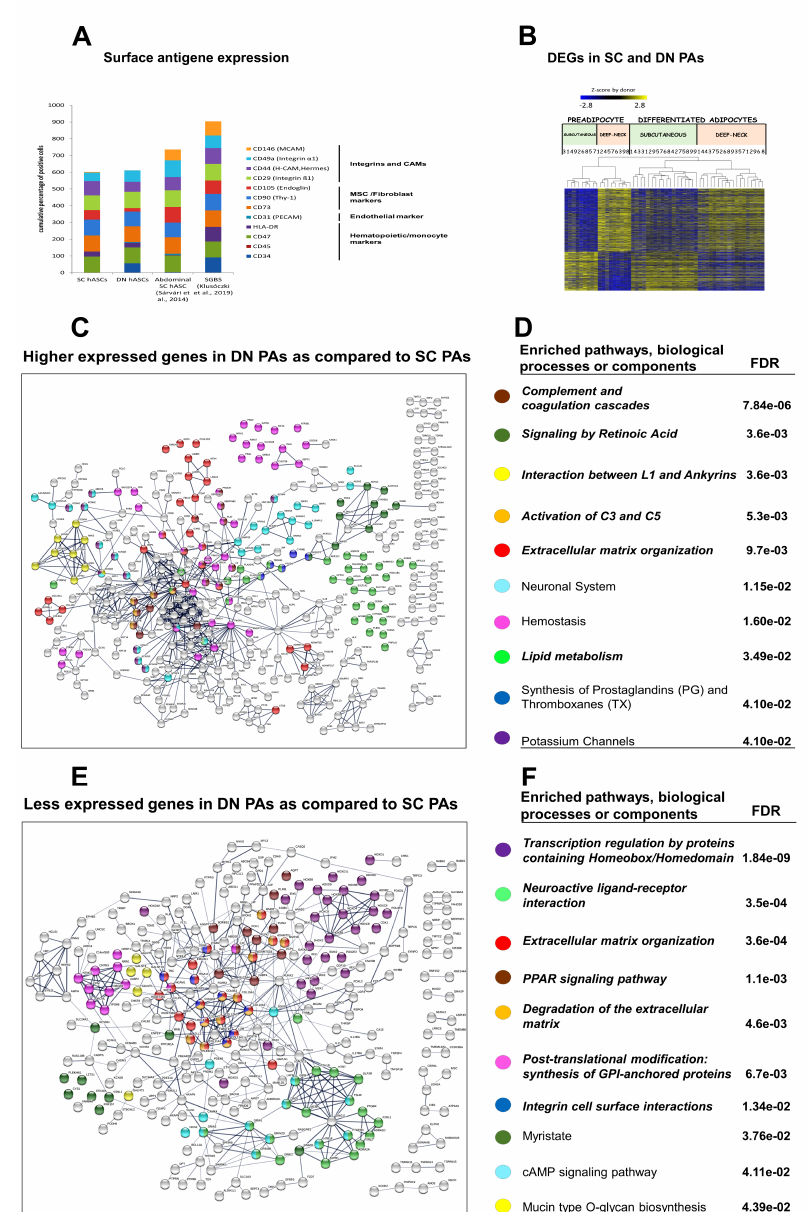
Figure 1. Characterization of subcutaneous (SC) and deep-neck (DN) progenitors. ( A ) Expression of 17 surface markers was determined in preadipocytes of three independent donors with T / C genotype for the rs1421085 locus in the FTO gene by flow cytometry. The numbers represent the percentage of positive cells. n = 3 ( B ) Heat map visualization of 1420 di ff erentially expressed genes (DEGs) in preadipocytes based on tissue origin; 1 to 9 labels the individual from which the sample was obtained. ( C , E ) Interactome maps of genes greater expressed in DN preadipocytes ( C ) and SC preadipocytes ( E ). Edges represent protein-protein based interactions; interaction score confidence value: 0.7. ( D , F ) Selected significant Enriched pathways, cell components or biological processes based on DN vs. SC DEGs in preadipocytes with false discovery rate (FDR) values; Italic font: pathway also appears after di ff erentiation ( D ) higher expressed in DN ( F ) and in SC preadipocytes; n = 9 donors, six samples /